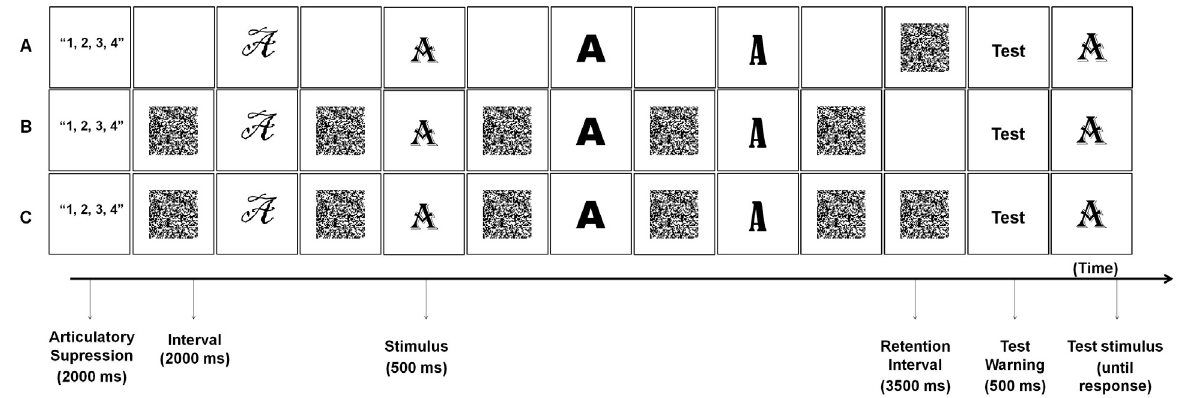
Figure 1 Scheme of the three experimental conditions. A: Dynamic visual noise (DVN) during retention interval; B: DVN during encoding; C: DVN during whole